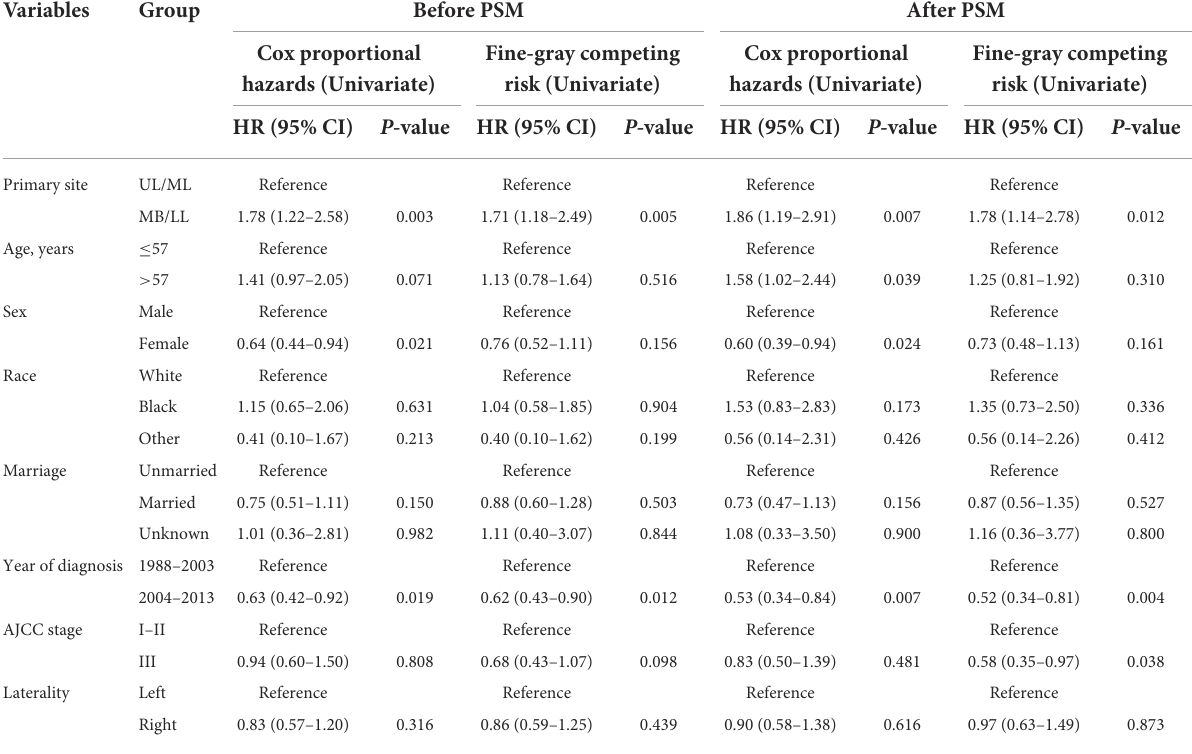
TABLE 4 Univariate Cox proportional hazards and Fine-Gray competing risk regression models for predictors of CVM before and after PSM.